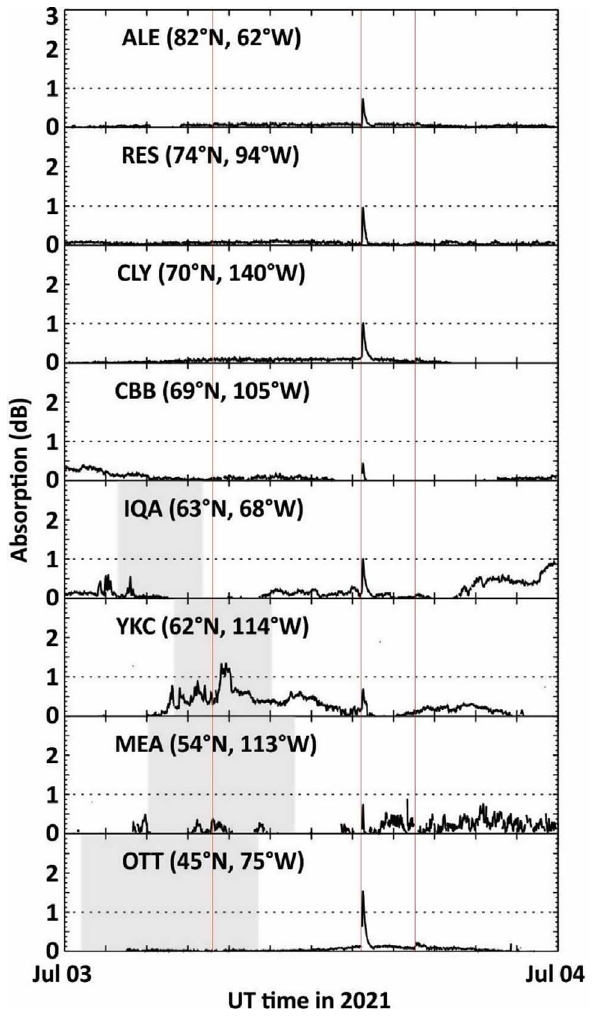
Fig. 3. Absorption at 30 MHz observed by Canadian riometer stations at the geographic coordinates noted. Grey shading indicates the time between sunset and sunrise when the station was located on the nightside. Red vertical lines indicate the onset, from left to right, of an M2.7, X1.6, and M1.0 solar X-ray fl